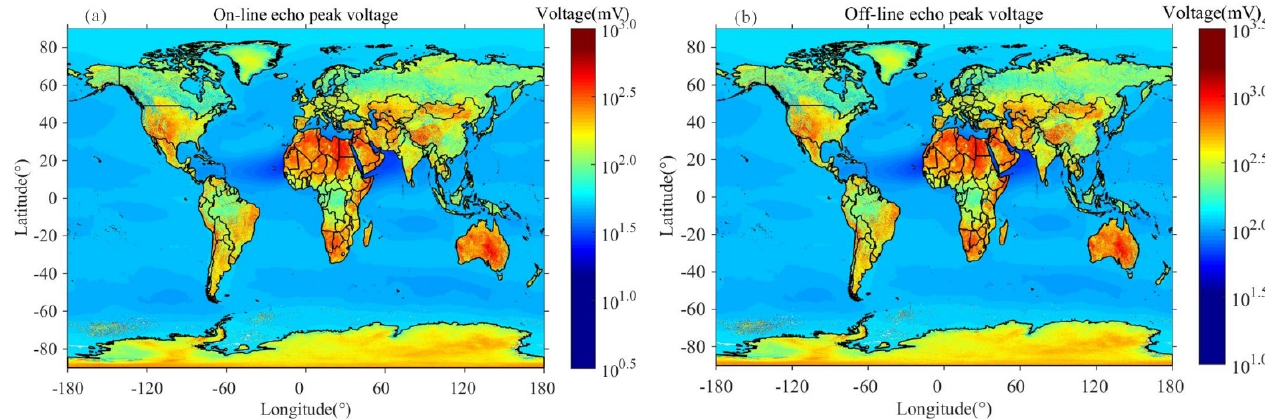
Figure 16. ( a ) Global online echo peak voltage distribution. ( b ) Global offline echo peak voltage distribution.